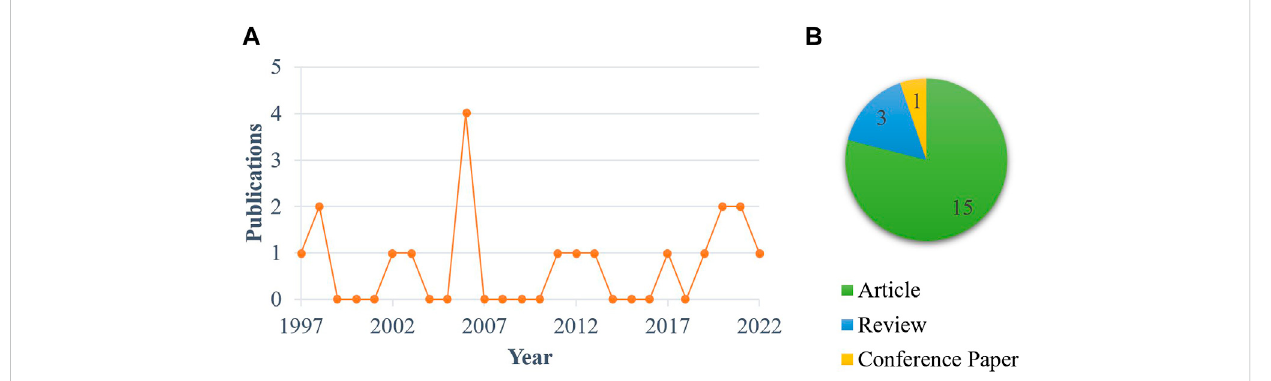
FIGURE 1 Publication trend (A) and type (B) of papers mentioning or focusing on argininein heat-stressed broilers. Note: The literature search was carried out by searching the Scopus database on September 12, 2022 entering the following query string: {TITLE [(chicken OR broiler) AND (arginine OR arg) AND heatANDstressANDNOT(arginineANDvasopressin)ANDNOTplantANDNOTpolymorphism]ORABS[(chickenORbroiler)AND(arginineORarg)AND heatANDstressANDNOT (arginineANDvasopressin) ANDNOTplantANDNOTpolymorphism]}.Norestriction onthedate andtypeofpublication was